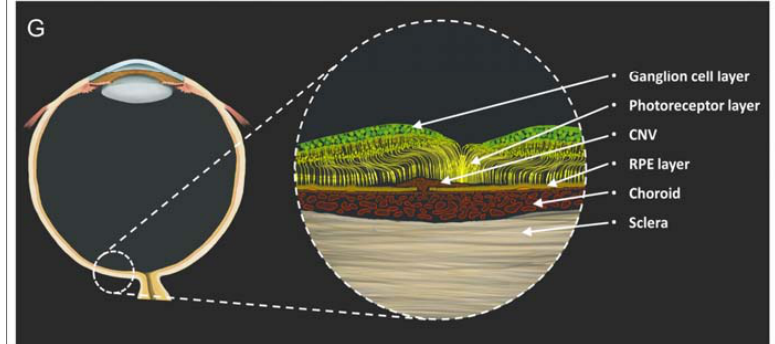
Figure 1. MMP10 is expressed in ARPE-19 cells, hRPE cells under basal conditions and in the control mouse and human retina. ( A ) ARPE-19 cells in transwell inserts expressing MMP10 (red). ( B ) hRPE cells expressing MMP10 (red) in coverslip. ( C ) Flat mount of WT mouse retina expressing MMP10 (red) on the RGCL. ( D ) Flat mount of WT mouse expressing MMP10 (red) on the RPE. ( E ) Flat mount of a control human expressing MMP10 (red) on the RGCL. ( F ) Flat mount of a control human retina expressing MMP10 (red) and lectin (green) on the RPE-choroid. ( G ) Human eye illustration with a magnification of the retinal in a case of CNV and the main cellular components mentioned in this manuscript, the layers mentioned in figures ( C – F ) are marked with an asterisk. Lectin (green) is observed in endothelial cells in vessels in mice and human retinas. DAPI and Hoescht (blue) label nuclei. CNV = Choroidal neovascularisation. MMP10 = Matrix metalloproteinase 10. RGCL = retinal ganglion cell layer. RPE = retinal pigment epithelium. Scale bar: 20 µ m ( A , B , D , F ), 50 µ m ( C , E ).